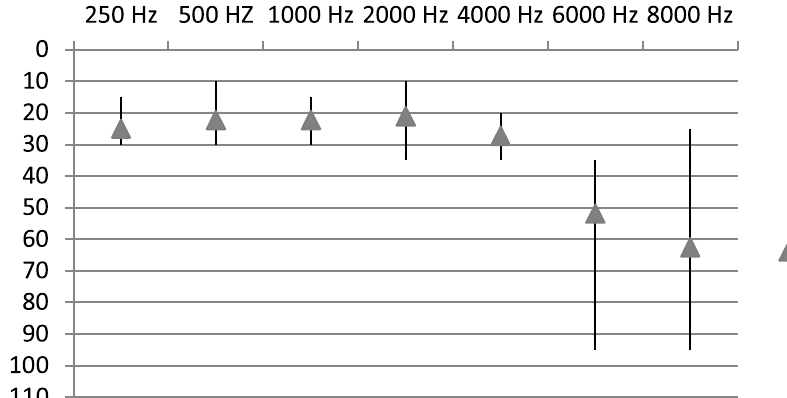
Fig. 4 The mean and range of CI-aided thresholds in